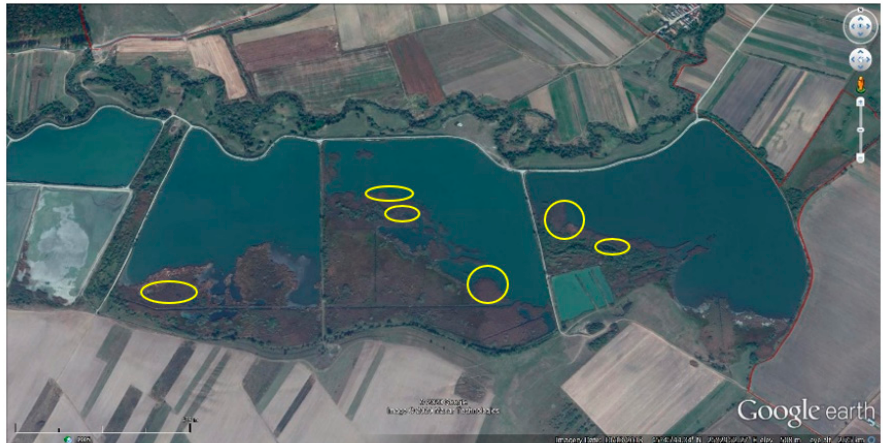
Figure 6. Colony location on fishponds from Dumbr ă vi ț a, 2010–2020 (yellow oval/circle, Ardea alba ).